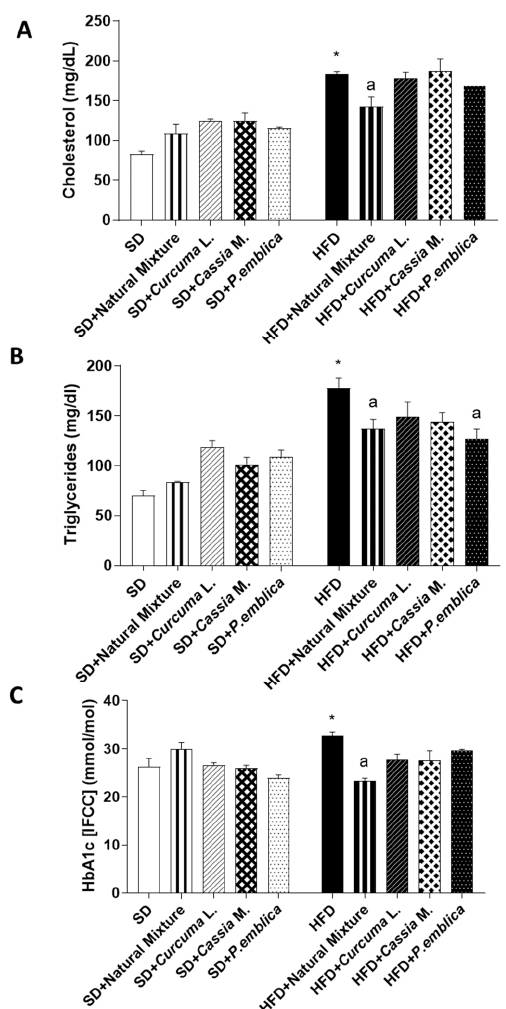
Figure 2. Effects of natural mixture, Curcuma L., Cassia M. and P. emblica on cholesterol ( A ), triglycerides ( B ) and glycated hemoglobin ( C ) in HFD- and SD-fed mice. Each column shows the mean ± SEM ( n = 6). One-way ANOVA and Tukey post hoc test results are as follows: *— p < 0.05 for significant difference vs. the SD group, and a — p < 0.05 for significant difference vs. the HFD group.